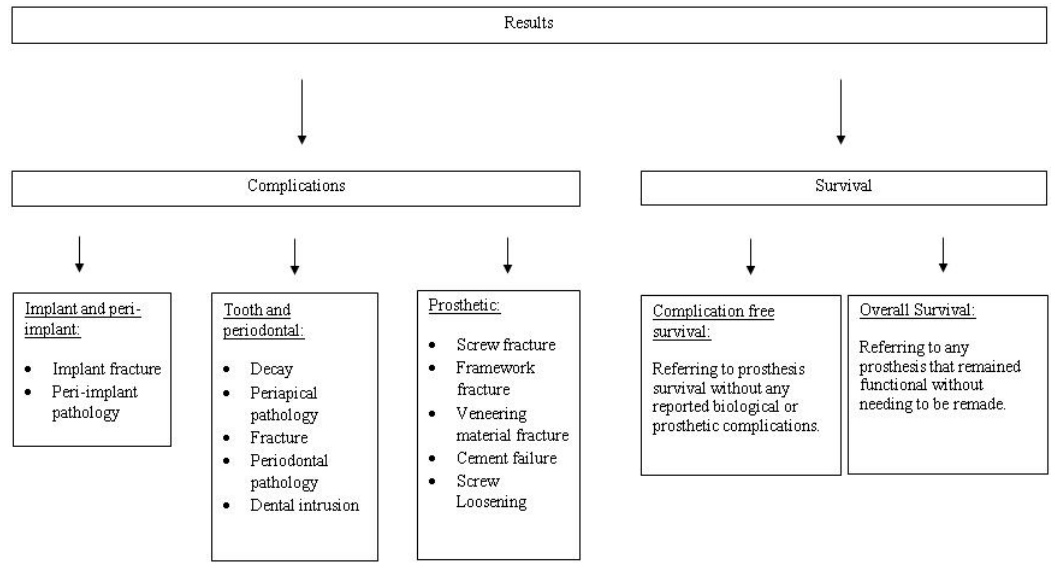
Figure 2. A flow diagram of outcomes assessed in this analysis.